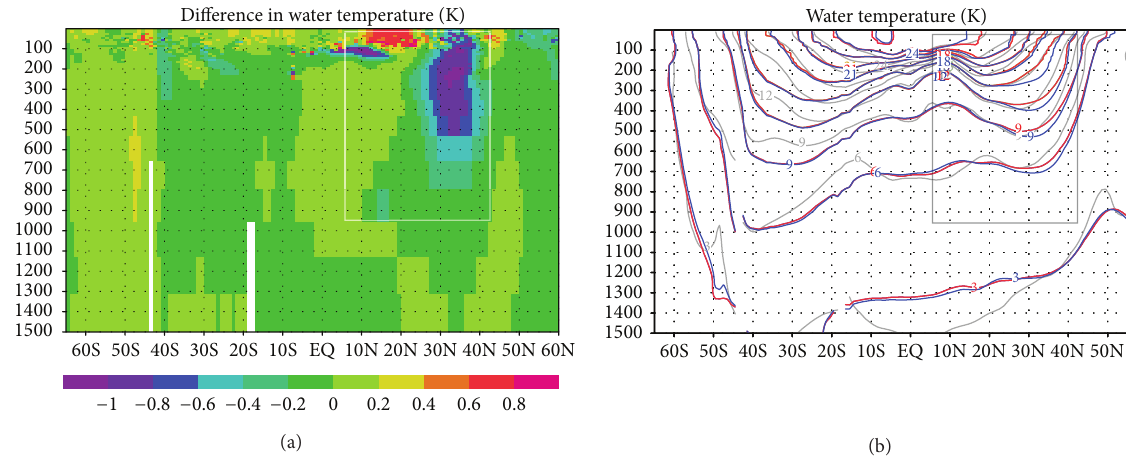
Figure 6: (a) Difference in mean water temperature (K) during 2001–2007 between GY and CT cases in a 1500 m vertical cross section along longitude 180 ∘ . (b) Mean water temperature for GY (red curves) and CT (blue) cases in a 1500 m vertical cross section along longitude 180 ∘ . Gray curves are mean values from the MOAA GPV observation dataset [15].